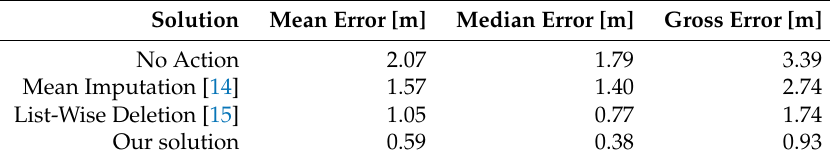
Table 3. Comparison of localisation errors for various preventing